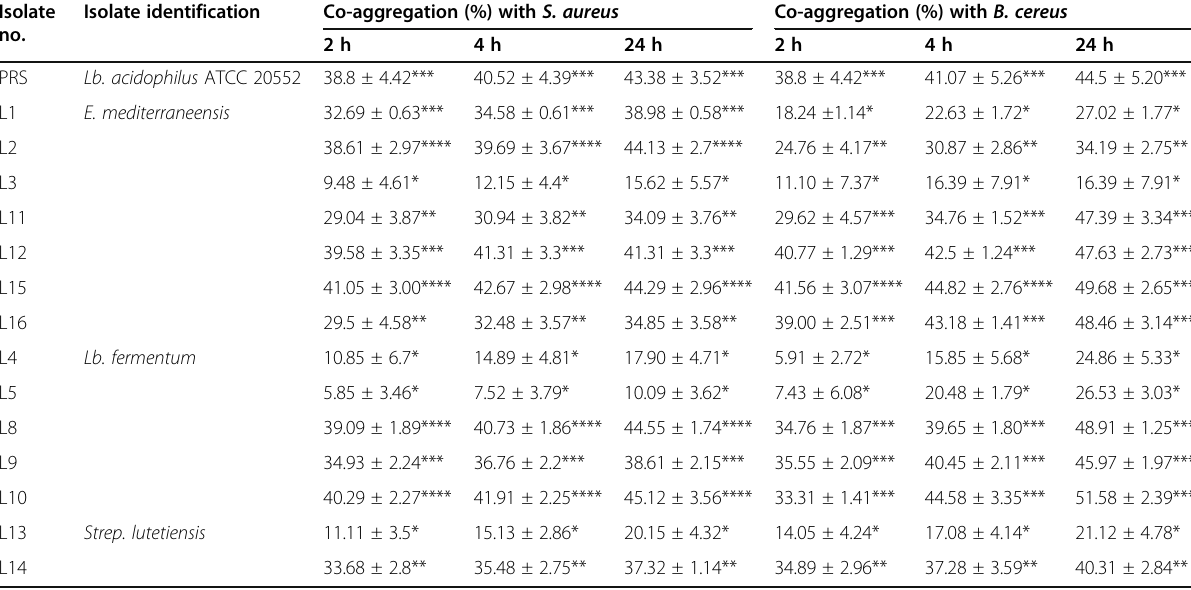
Table 9 Co-aggregation ability between isolated LAB and toxigenic bacteria S. aureus and B. cereus Isolate no.